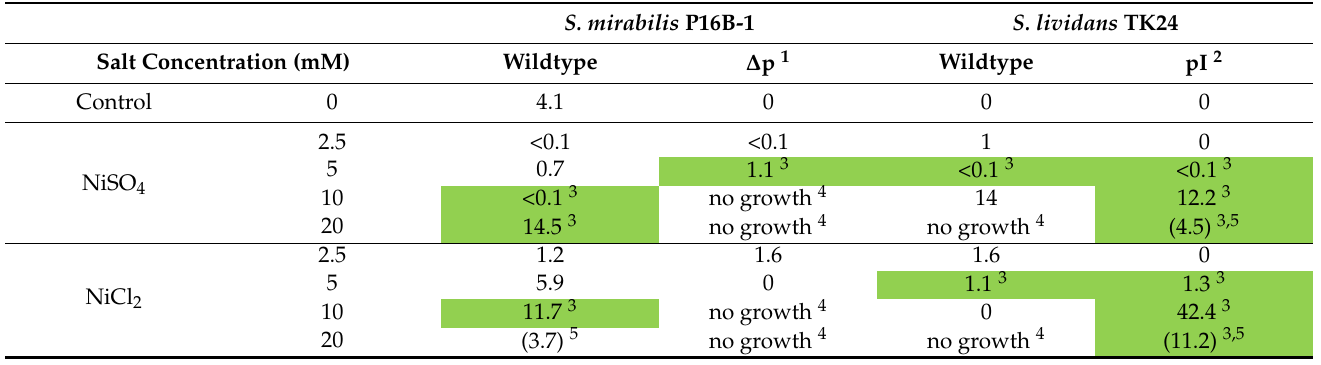
Table 1. Mineral yield (mg) from solid